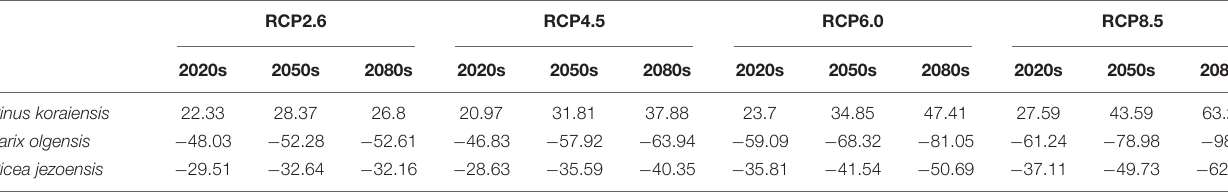
TABLE 4 | RV values for the three periods based on tree-ring climate relationship. RCP2.6 RCP4.5